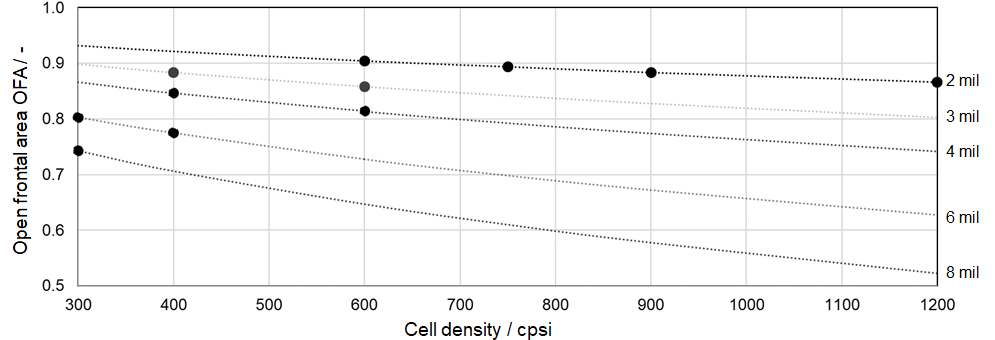
Figure 6. Open frontal area of monoliths with respect to their cell density and wall thickness.